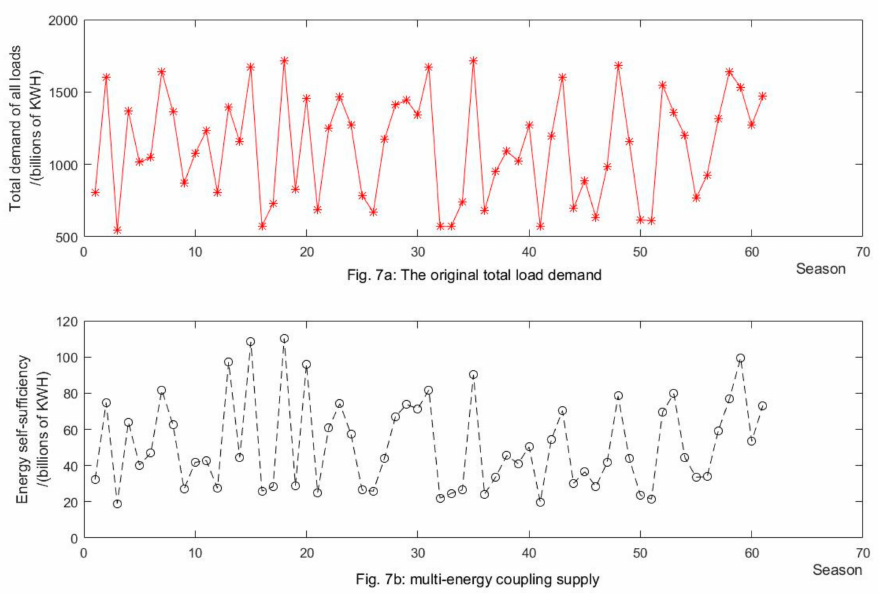
Figure 7. Aggregate demand data and multi-energy coupling data.( a ) The original total load demand; ( b ) Multi-energy coupling supply.